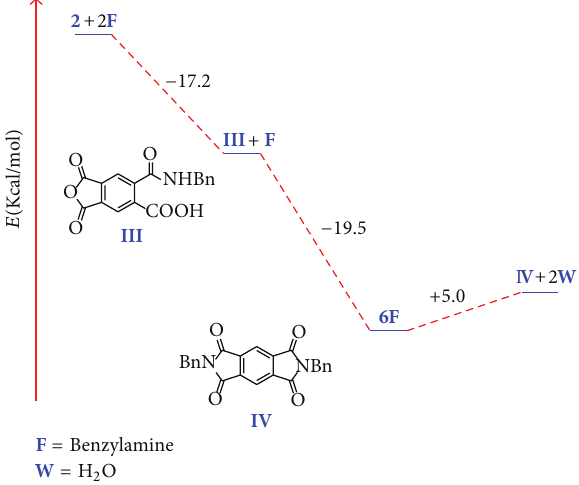
Figure 8: Energy diagram for the reaction pathway of dianhydride 2 and benzylamine.